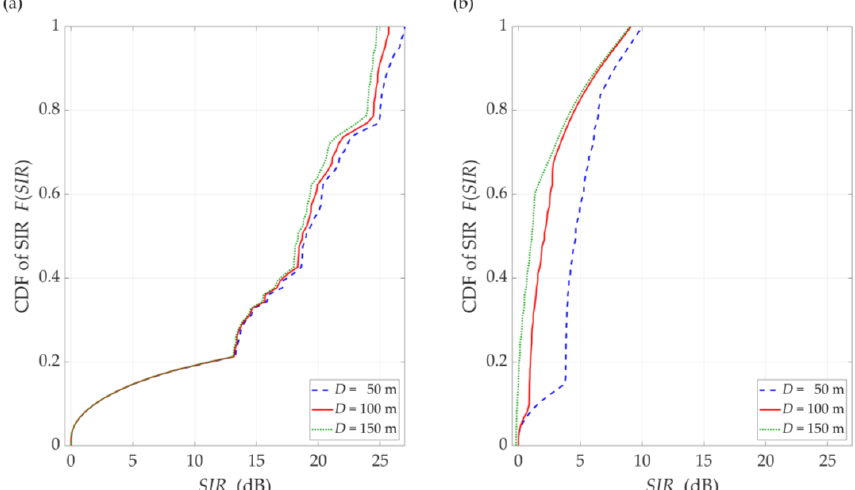
Figure 8. CDFs of SIR for DL scenario, selected D = {50, 100, 150} m, under ( a ) LOS (TDL-D) and ( b ) NLOS (TDL-B) conditions.